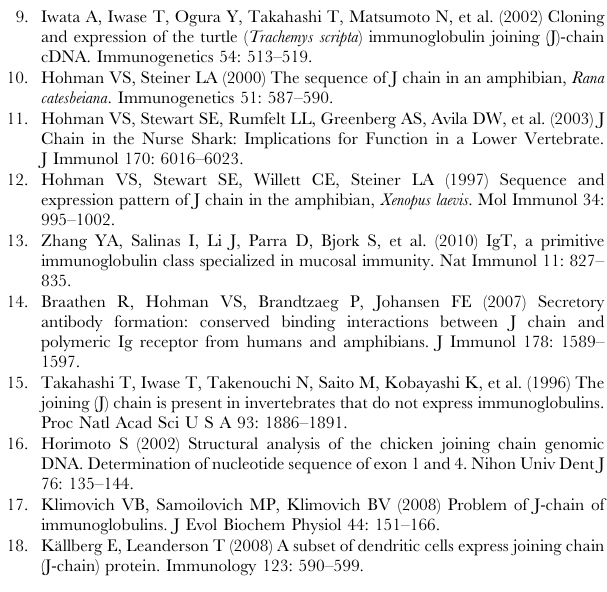
Figure S1 Nucleus to cytoplasm ratio of P. dolloi gut lymphocytes (asterisks) (A) and gut epithelial cells (GECs) (B). Cryosections were stained with the nuclear stain DAPI and the fluorescent images (blue) were overlaid with their corresponding differential interfer- ence contrast (DIC) image. L: lumen.